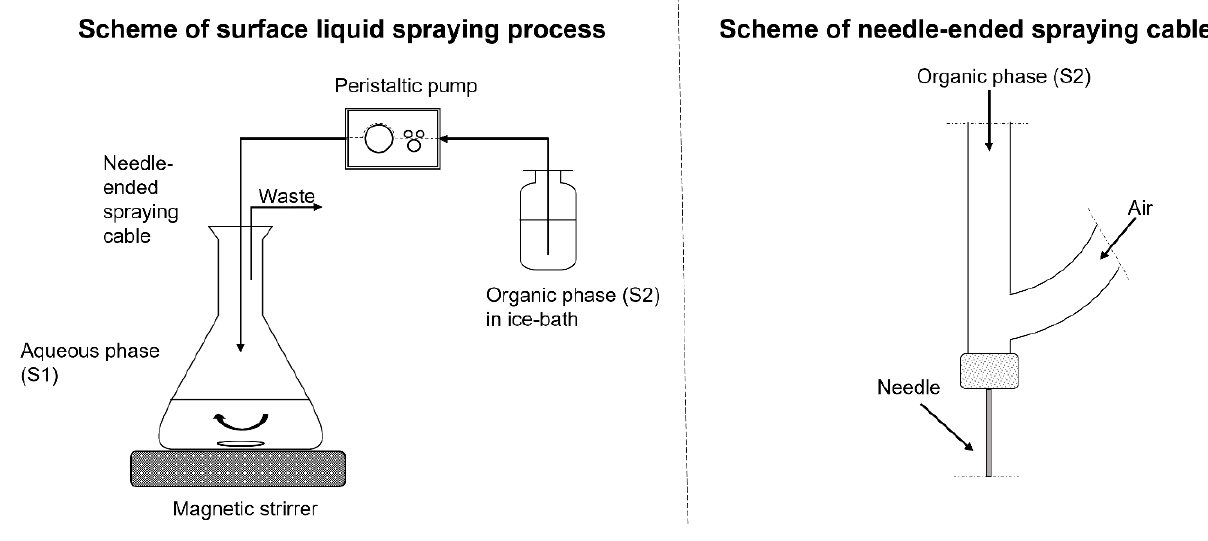
Figure 8. Instrumental setup for PM preparation. Table 9. Composition of the fabricated material, in brief.